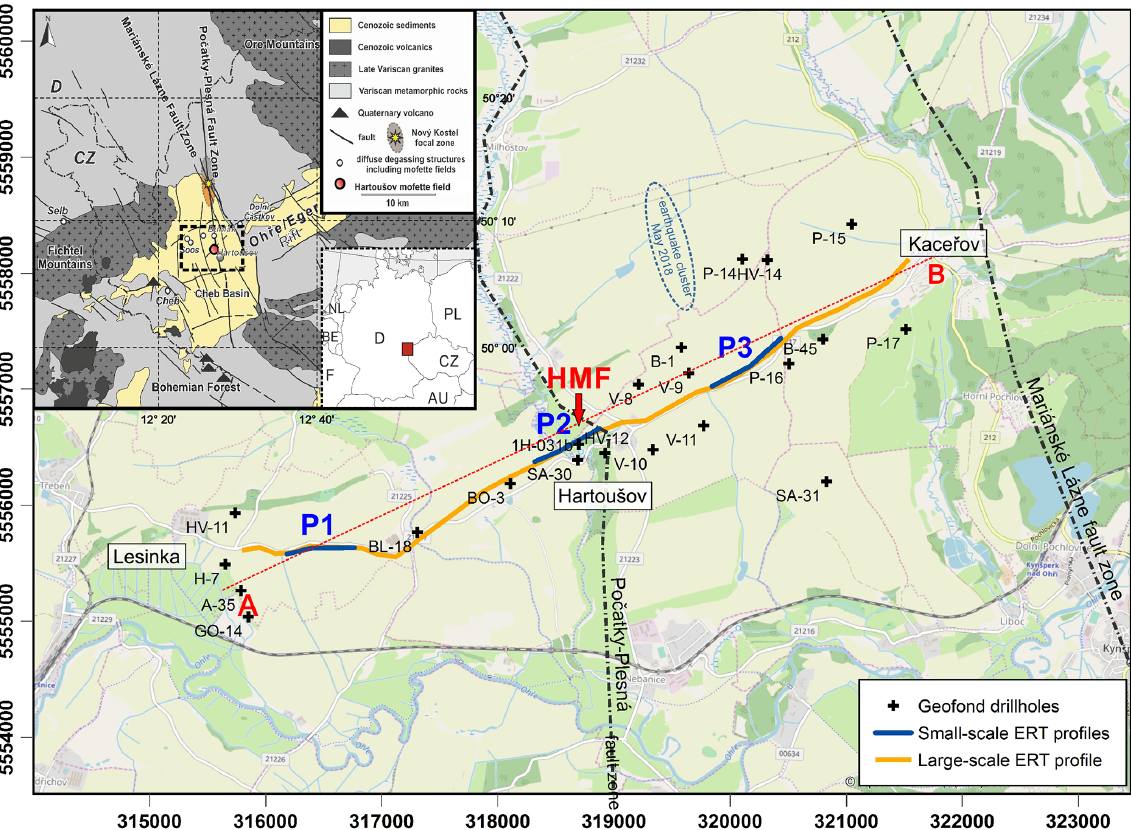
Figure 1. Map of the measured large-scale ERT profile (6.5km), small-scale 625–700m long ERT profiles (P1, P2, P3), and existing drill holes (Czech Geological Survey) with lithological information. All coordinates are in UTM zone 33N. The red dotted line marks the location of the lithological transect in Fig. 2. The Poˇcatky–Plesná zone (PPZ) and Mariánské Láznˇe fault zone (MLF) are drawn as the main tectonic features. HMF: Hartoušov mofette field. Inset: geological sketch map of the western Bohemia–Vogtland area and the Cheb Basin near the German–Czech border in Central Europe, modified from Flechsig et al. (2008), Dahm et al. (2013), and Bussert et al. (2017).